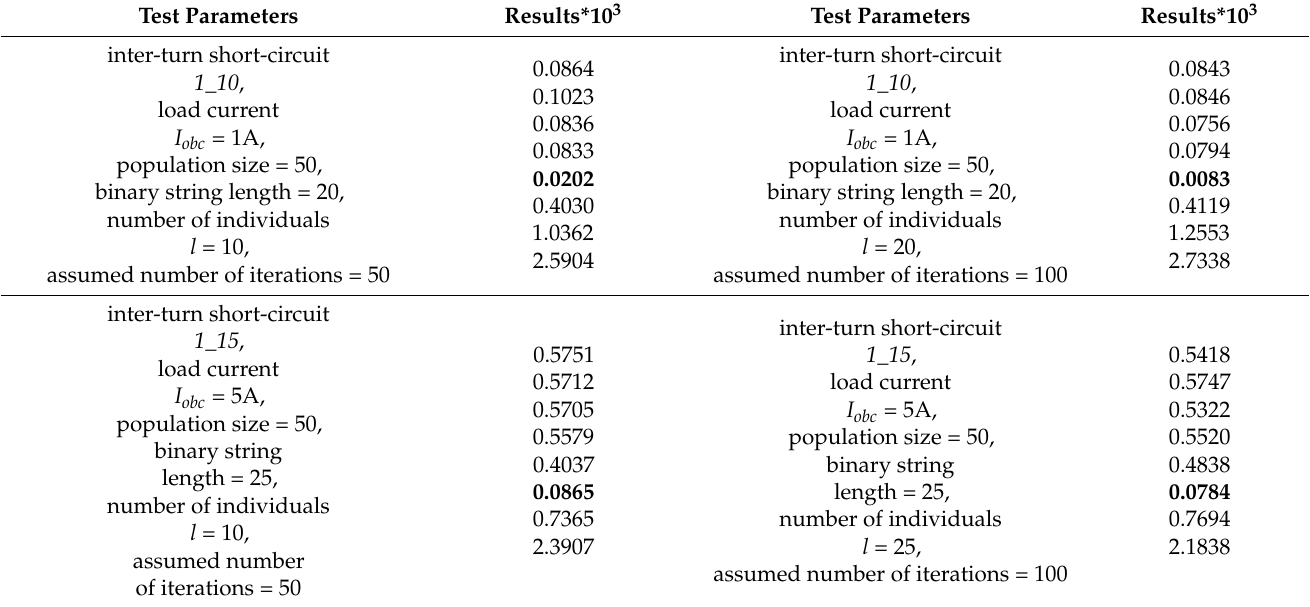
Table 1. Example results of matrix H 1 tests for electromagnetic torque m el .